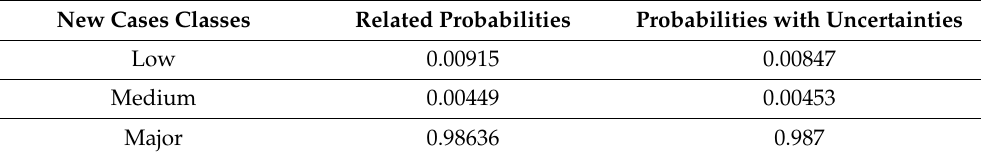
Table 12. New cases classes probabilities. Results obtained by collocation.